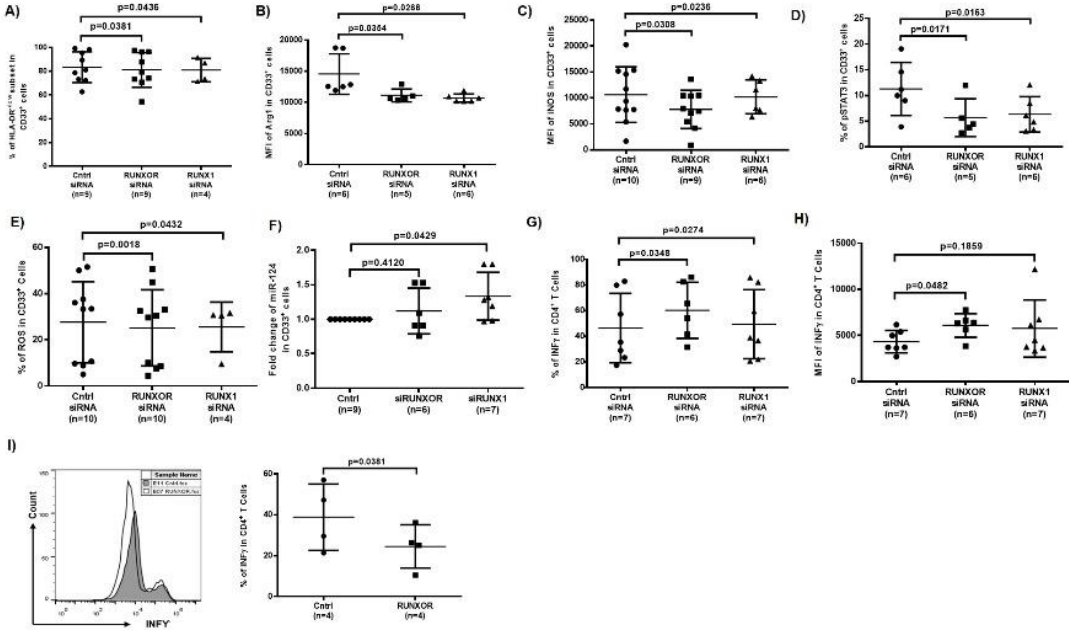
Figure 6. Silencing RUNXOR or RUNX1 inhibits the differentiation of MDSCs and their suppressive functions. ( A ) Silencing of RUNXOR or RUNX1 in HCV-CD33 + cells reduces the maturation of myeloid cells (HLA-DR − / low subset in CD33 + ). ( B – F ) Silencing RUNXOR or RUNX1 in HCV-CD33 + decreases the Arg1, iNOS and pSTAT3 and increases miR-124 expression. ( G , H ) The percentage and MFI